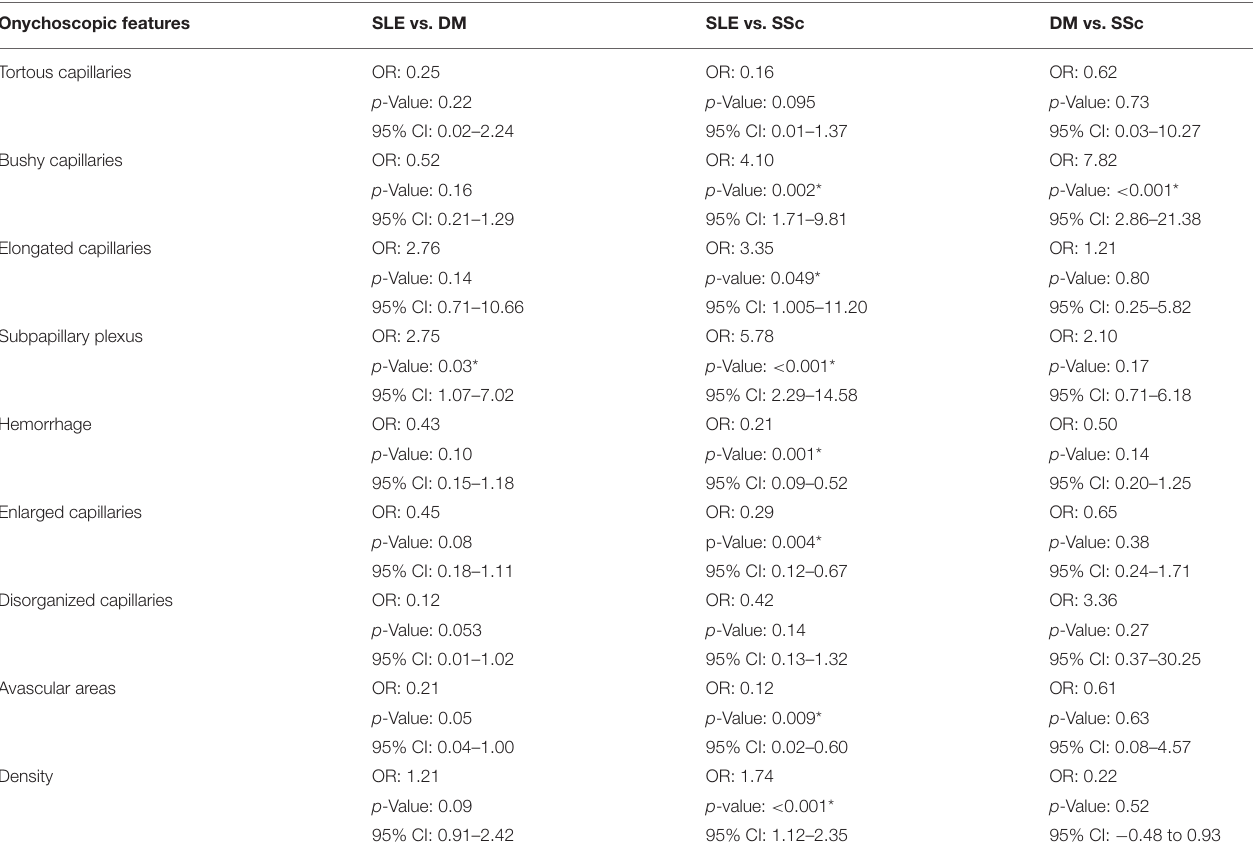
TABLE 3 | Multinomial logistic regression analysis of onychoscopic features in SLE, DM, and SSc patients. Onychoscopic features SLE vs. DM Tortous